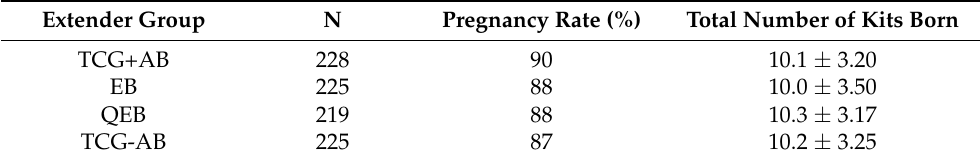
Table 3. Fertility (%) and prolificacy (means ± standard deviation) obtained from insemination of 897